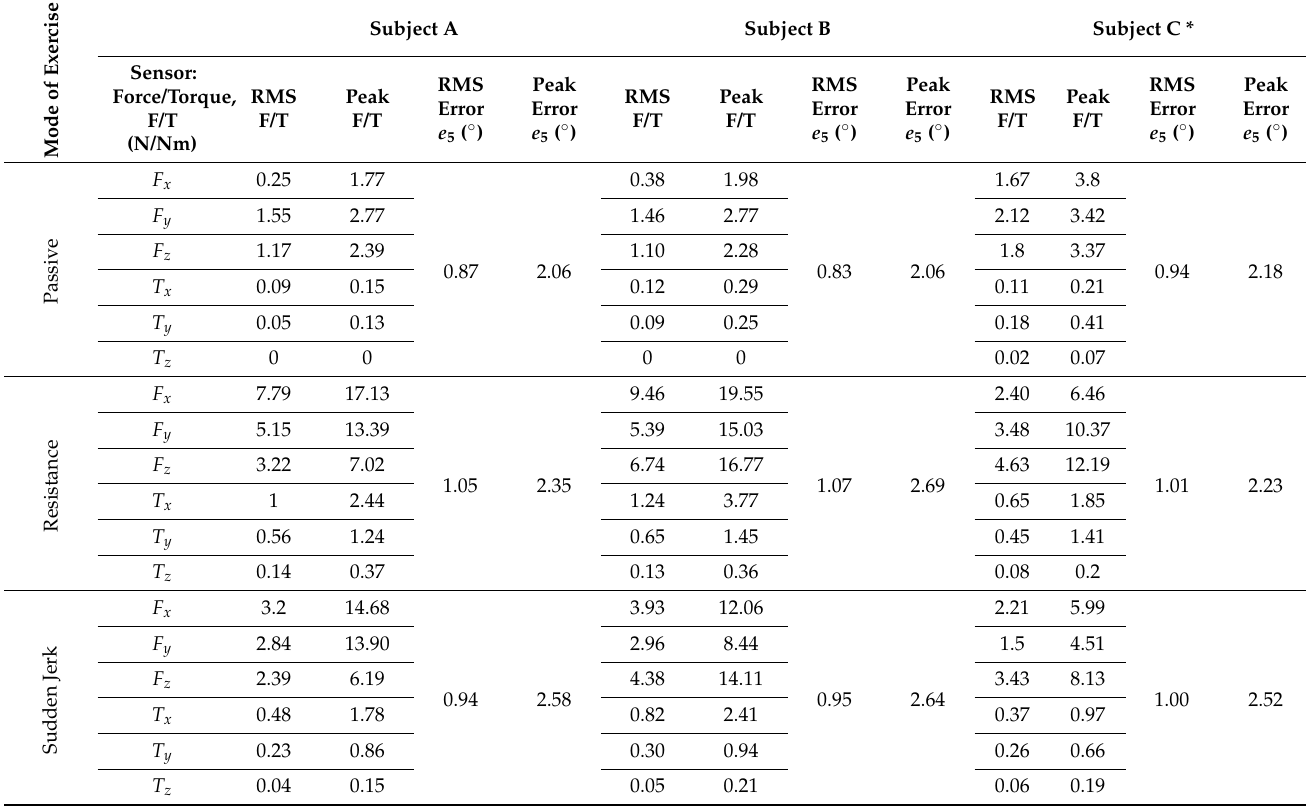
Table 6. Joint 5: Forearm pronation/supination passive